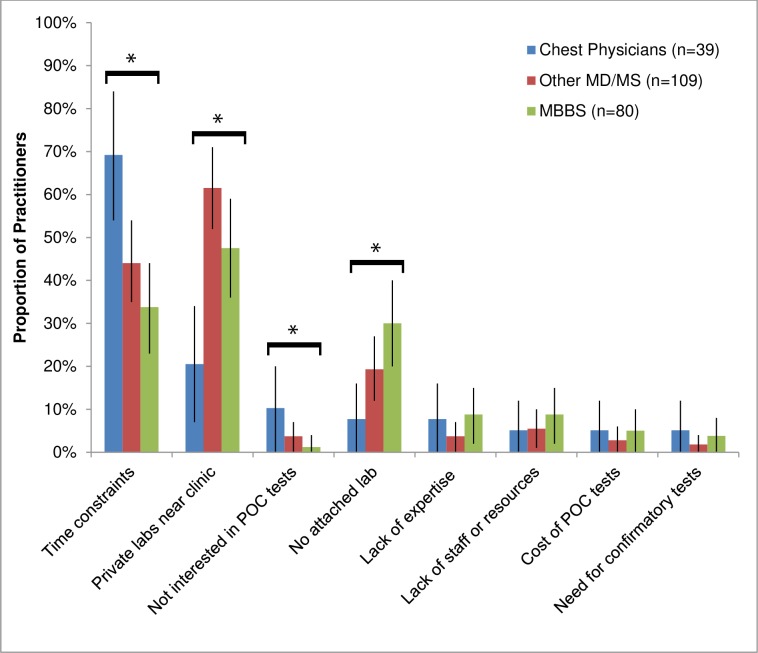
Distribution of challenges in performing point-of-care tests in-house according to practitioners’ level of training (n = 228).Practitioner-reported reasons for not performing rapid point-of-care tests in their health facility among 228 randomly selected private practitioners in Chennai. Practitioners gave multiple responses; thus, response categories are not mutually exclusive. Figures show the distribution of PP-reported challenges in performing POC tests in-house by practitioners’ specialty and level of training. Statistically significant differences across practitioners’ level of training included: time constraints (listed by 69% of chest physicians versus 40% of non-chest specialists, P<0.001), use of nearby private lab services (21% versus 56%, p<0.001), lack of interest in POC tests (10% versus 3%, P = 0.03), and lack of an attached lab (8% versus 24%, p = 0.03). Error bars represent 95% confidence intervals for each estimate. *Indicates statistically significant differences across level of training comparing chest physicians versus non-chest specialists.